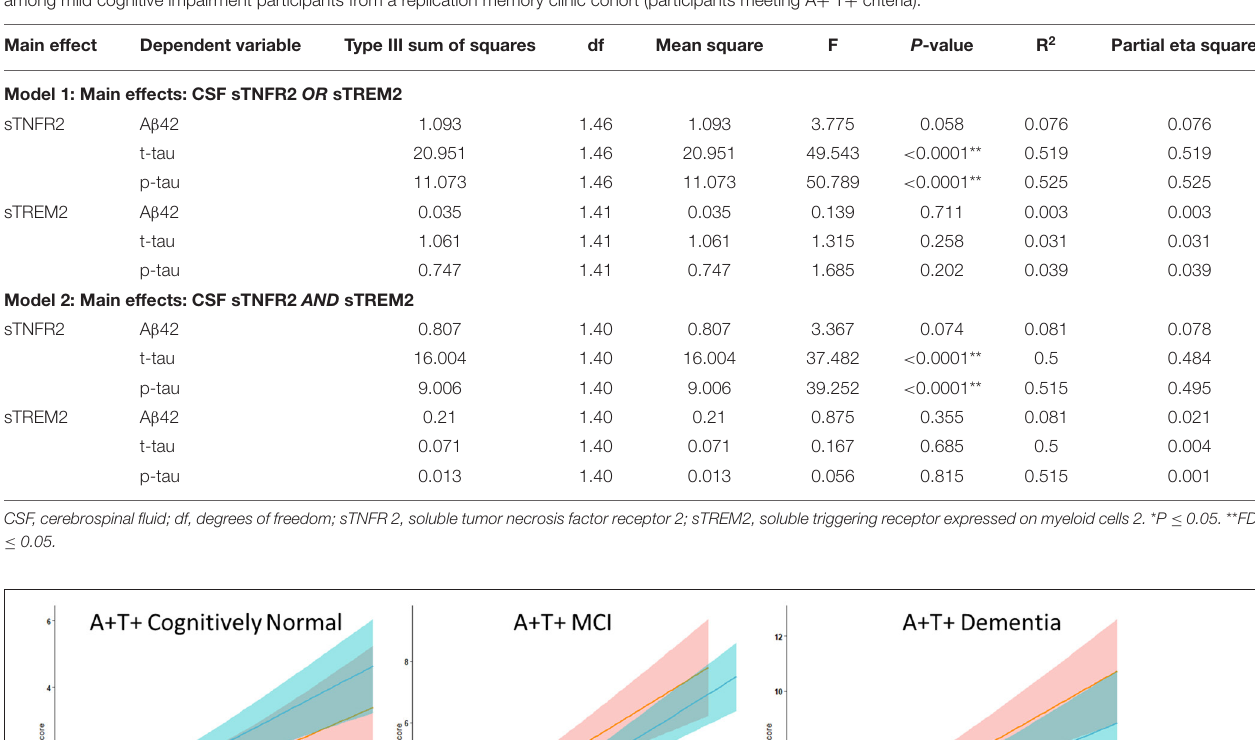
TABLE 5 | Key results of the general linear model with CSF A β 42, t-tau, and p-tau as the dependent variables and covariates: age, sex, education, APOE ε 4 status, among mild cognitive impairment participants from a replication memory clinic cohort (participants meeting A + T + criteria).